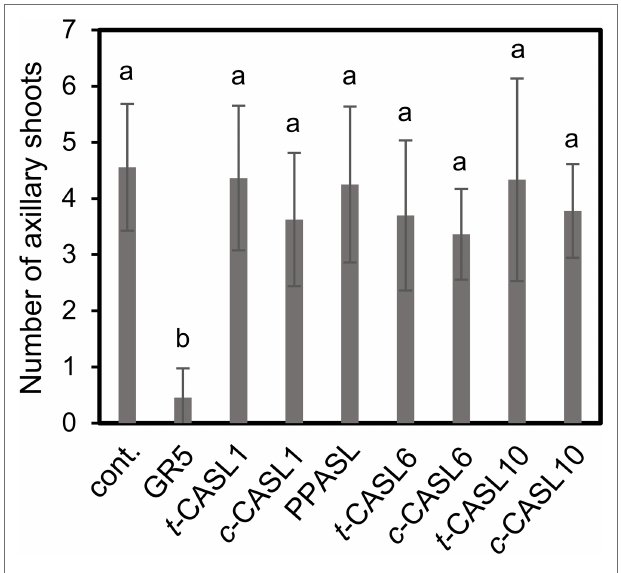
FIGURE 6 | Shoot branching inhibiting activity of CASLs using the Arabidosis max4 mutant. Number of axillary shoots (Over 5 mm) of max4 which were grown in hydroponic culture containing test compounds at 1 μ M concentration was counted. Data are means ± SD ( n = 8–11). Different letters indicate significant differences at p < 0.05 with Tukey multiple comparison test. cont. means control with only acetone at 0.1%.